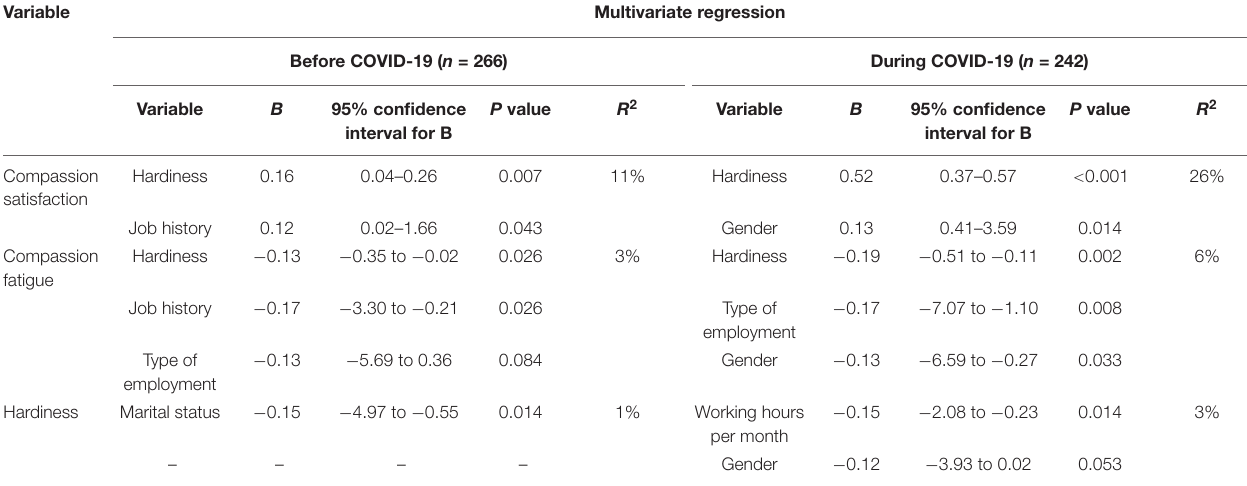
TABLE 4 | The comparison of multiple regression analysis summary for compassion satisfaction, compassion fatigue and hardiness before COVID-19 and during COVID-19.